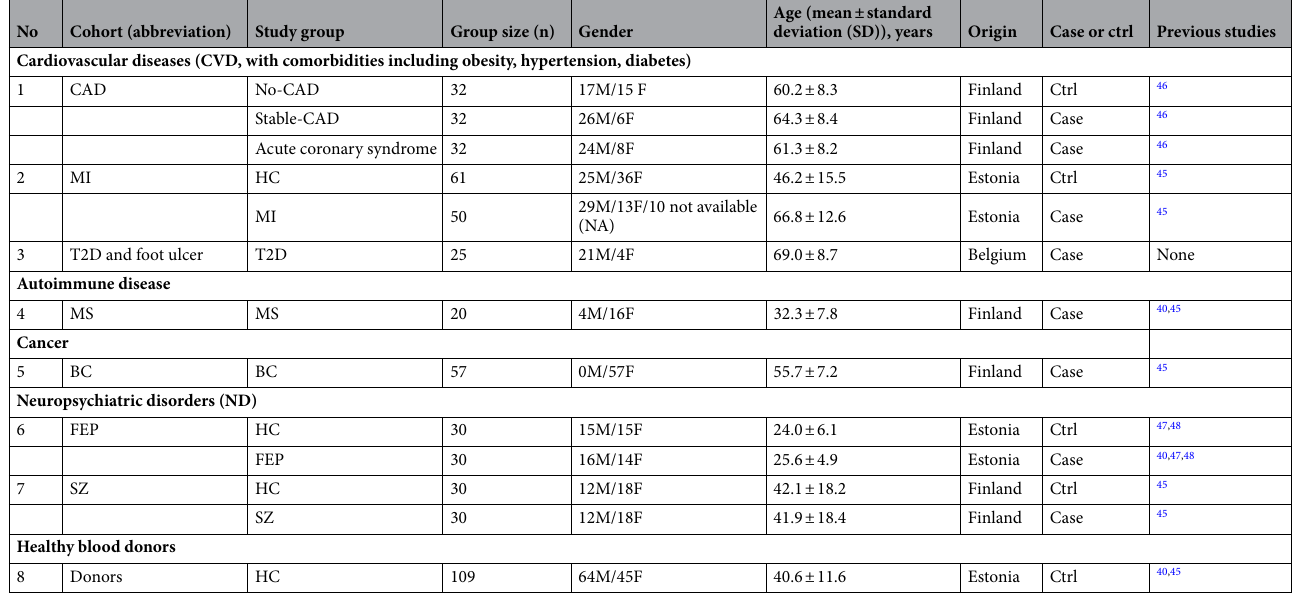
Table 1. Descriptions of clinical cohorts of COVID-19 naïve